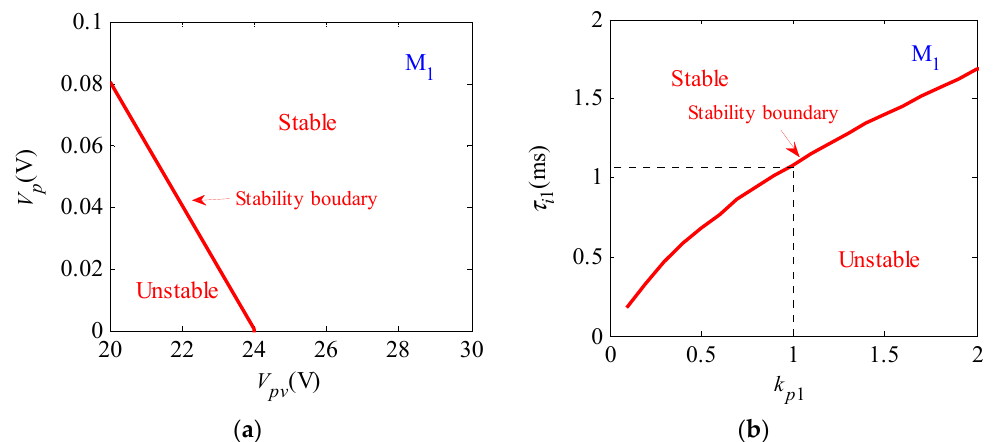
Figure 7. The parameter space of control parameters at the worst operating condition in M 1 : ( a ) The parameter space of V pv and V p ; ( b ) The parameter space of “Regulator1”.